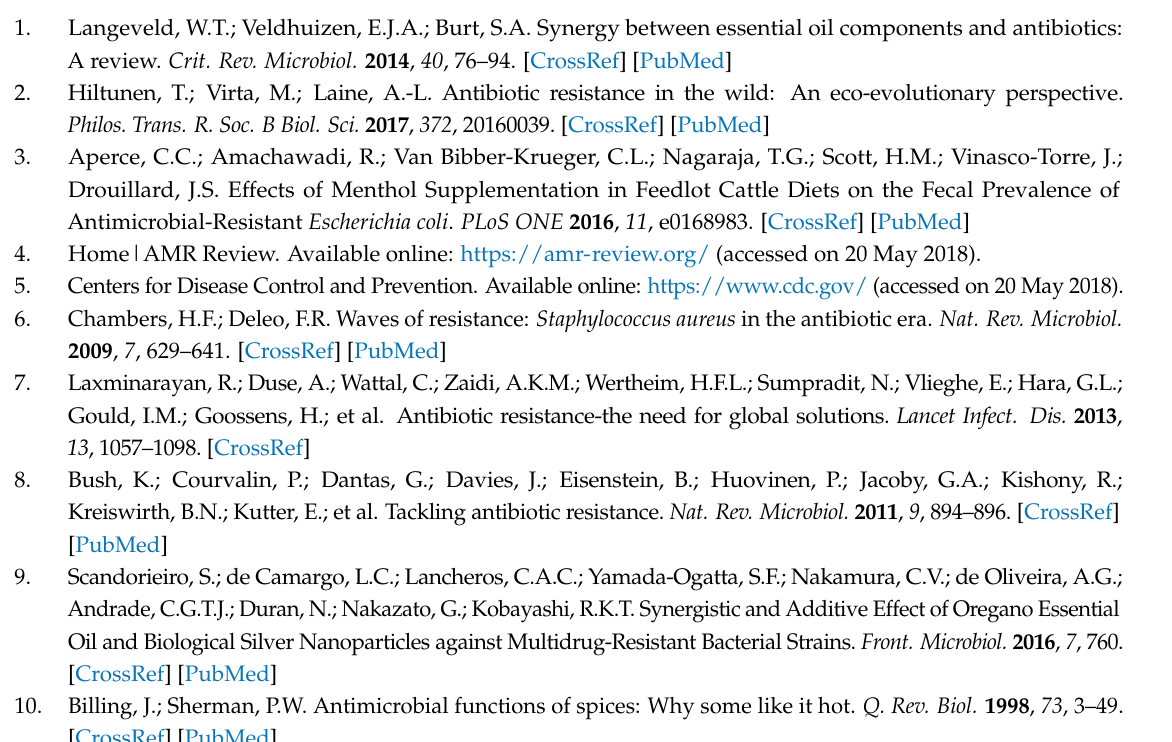
and thymol active compounds, Figure S2: Flow cytometry histograms at MBC on S. aureus and E. coli , Figure S3: S. aureus and E. coli confocal images after treatment with carvacrol, cinnamaldehyde and thymol, Figure S4: Synergistic effects of the EO molecules assayed against S. aureus